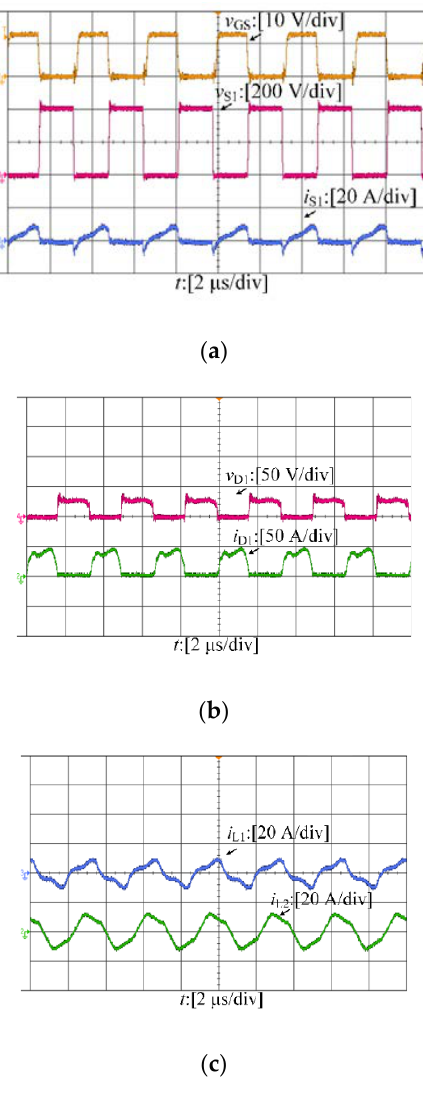
Figure 15. Experimental results at rated condition ( a ) waveforms of power switch S 1 , ( b ) waveforms of diode D 1 and ( c ) waveforms of currents i L1 , i L2 .